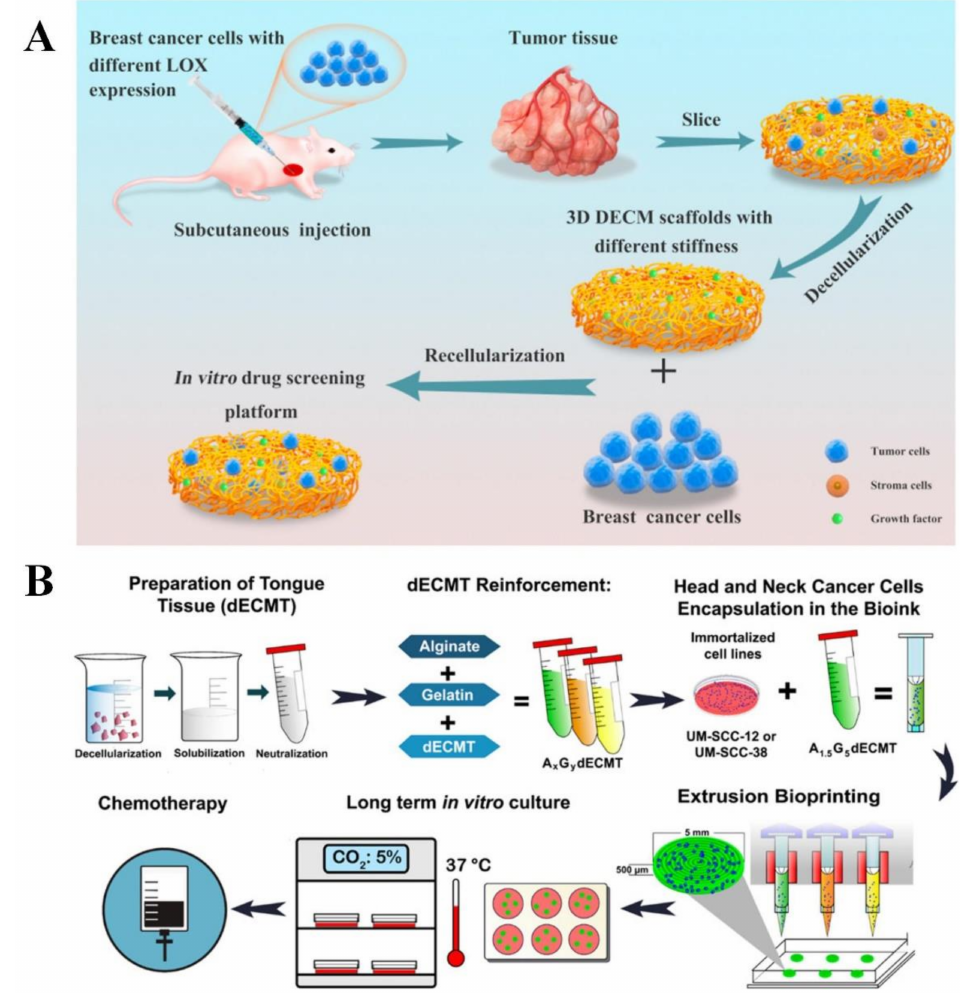
Figure 4. Scaffold-based cancer model. ( A ) Preparation of decellularized extracellular matrix scaf- fold with different stiffness for in vitro cancer model development. Adapted with permission from [76] © Creative Commons Attribution License (2021). ( B ) Fabrication of a mechanically sta- ble bioprinted scaffold-based cancer model. Adapted with permission from [77] © ACS Publica- tions